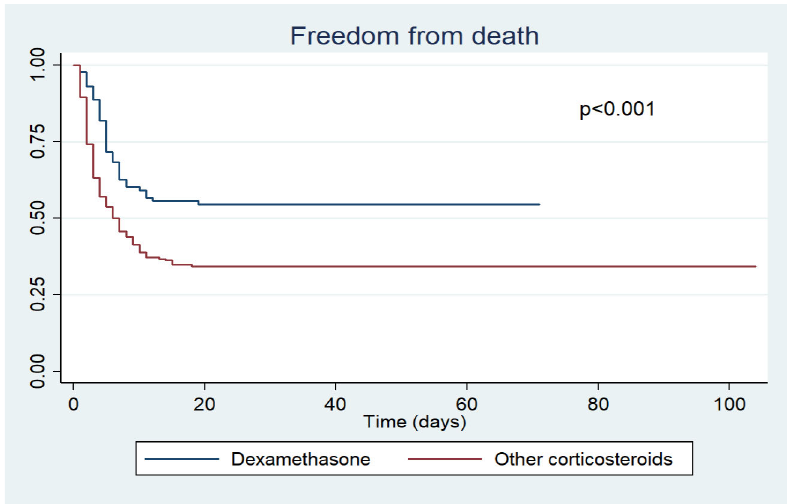
Figure 3. Survival analysis by group of corticosteroids received.